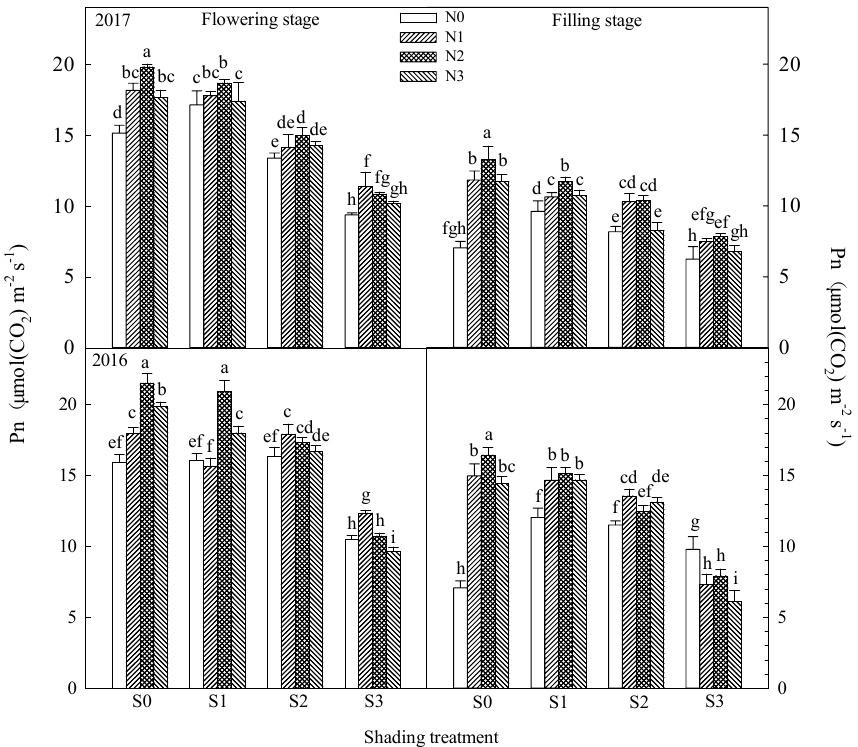
Figure 2. Effect of light and nitrogen treatment on the net photosynthetic rate (Pn) of wheat. Bars indicate SD (n = 3). Values within columns followed by the same letter are statistically insignificant at the 0.05 level.